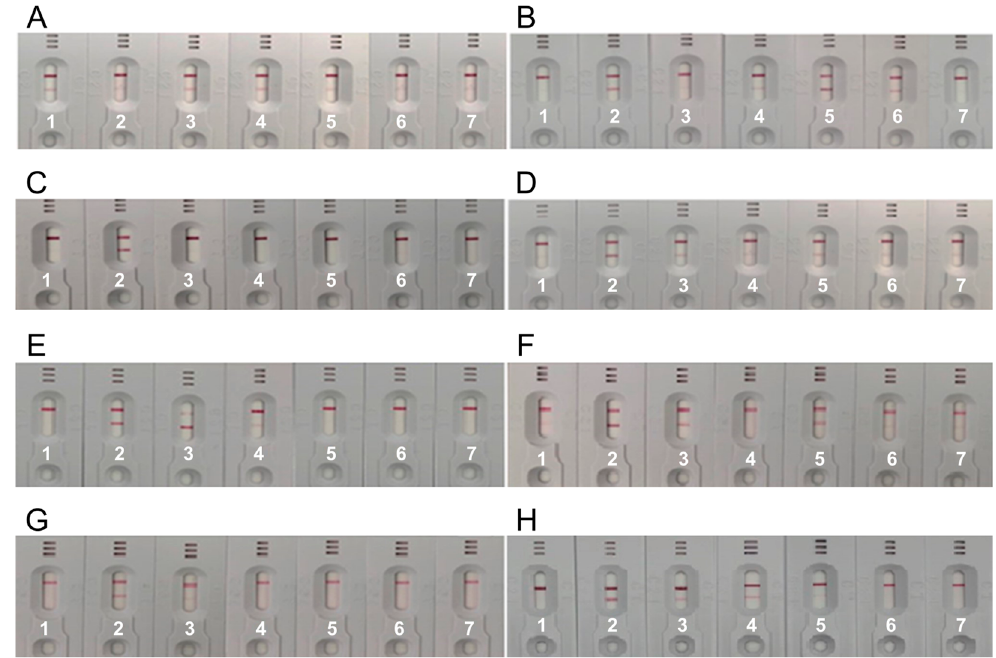
Figure 5. Specificity of the NT-proBNP rapid diagnosis kit. Letters “C” and “G” stand for Capture and Gold, respectively. ( A ) C2H2(C)/C1G3(G); ( B ) C3B11(C)/C1G3(G); ( C ) C1G3(C)/C2H2(G); ( D ) C3B11(C)/C2H2(G); ( E ) C4D6(C)/C2H2(G); ( F ) C3B11(C)/C3B11(G); ( G ) C2H2(C)/C4B12(G); ( H ) C3B11(C)/C4B12(G).